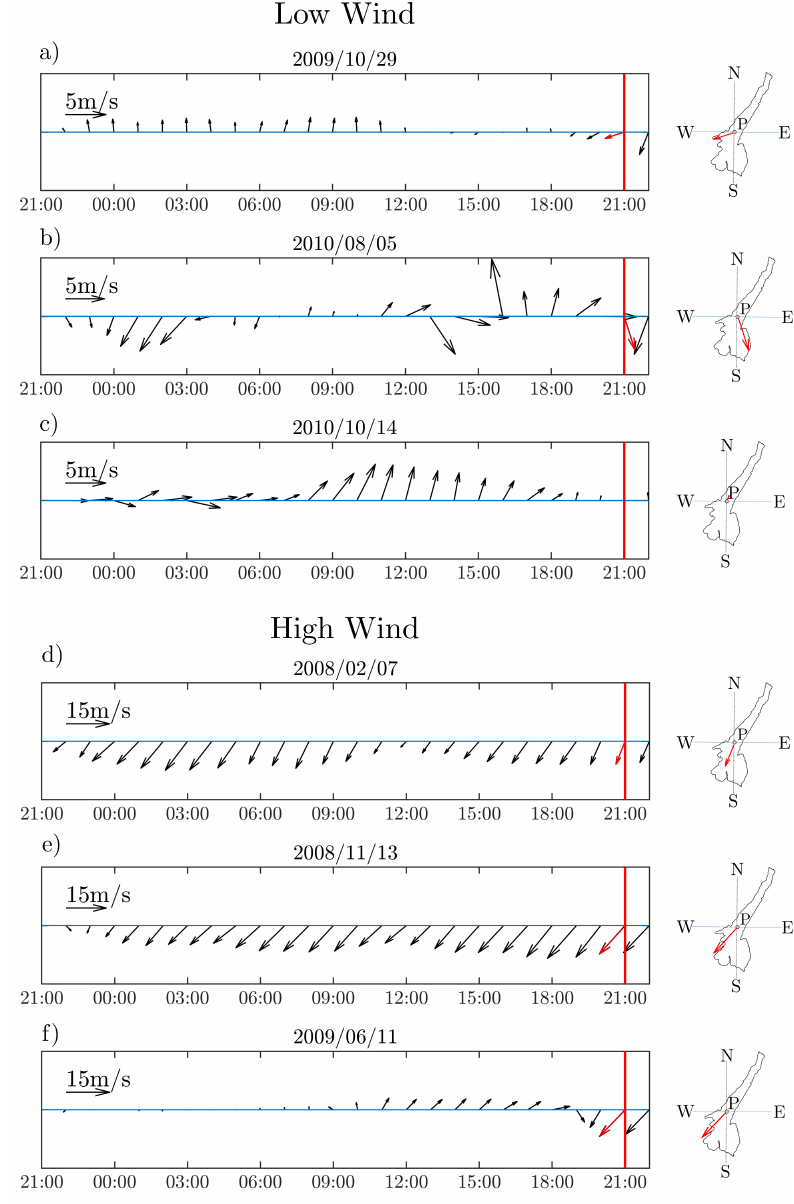
Figure 4. Simulated wind direction and speed on the investigated dates a in-lake point (point P in Figure 1a). The red arrow in each panel corresponds to the wind simulated in P at the SAR acquisition time (i.e., the red line at 21:00 UTC). The sketch at the right displays the location of P and the direction of the wind with respect to the lake